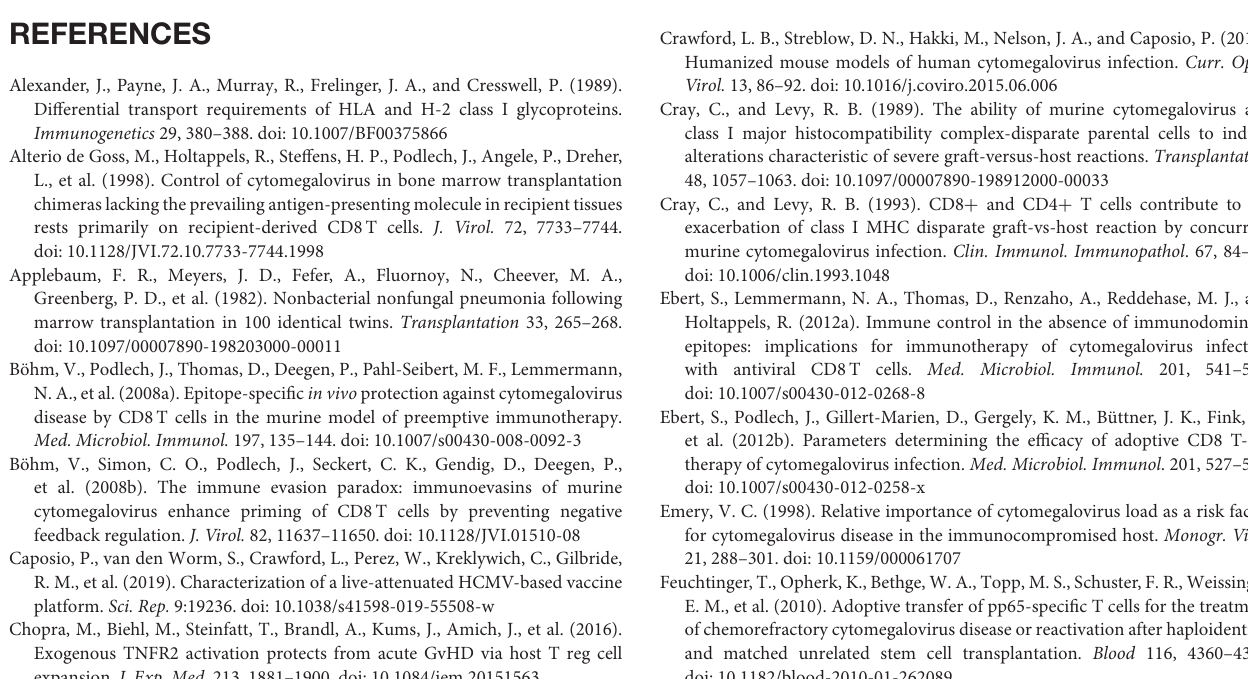
Figure S1 | GvH-reactive CD8 + T cells recognize MHC class-I molecules that present cellular peptides. A cytolytic T-lymphocyte (CTL) line was raised by stimulating BALB/c-H2 dm2 (L d -negative) spleen cells with BALB/c (L d -positive) spleen cells in a classical “mixed lymphocyte reaction.” After two rounds of stimulation, cells of the short-term line were tested as effector cells for the recognition of TAP-sufficient (L and L Ld ) or TAP-deficient (T2 and T2 Ld ) target cells. (A) Percentage of cells of the CTL line that respond with IFN γ secretion in an ELISpot assay. Error bars represent 95% confidence intervals determined by intercept-free linear regression. (B) Cytolytic activity determined in a [Cr 51 ]-release assay at the indicated effector-to-target cell (E:T) ratios. Figure S2 | Patterns of TCR V β chain usage in CD8 + memory T-cell populations. (A,B) , identically performed experiments revealing V β chain usage patterns in immunomagnetically-purified, spleen-derived CD8 + T cells at 7 or 8 months, respectively, after intraplantar mCMV infection. (Top panels, all TCR + ) Cytofluorometric analysis of V β x expression by all CD8 + T cells. (Center panels, IE1-TCR + ) Gating on cells stained with IE1 peptide-L d multimers. (Bottom panels, m164-TCR + ) Gating on cells stained with m164 peptide-D d multimers. Bars and numbers show the percentages of cells expressing the indicated V β